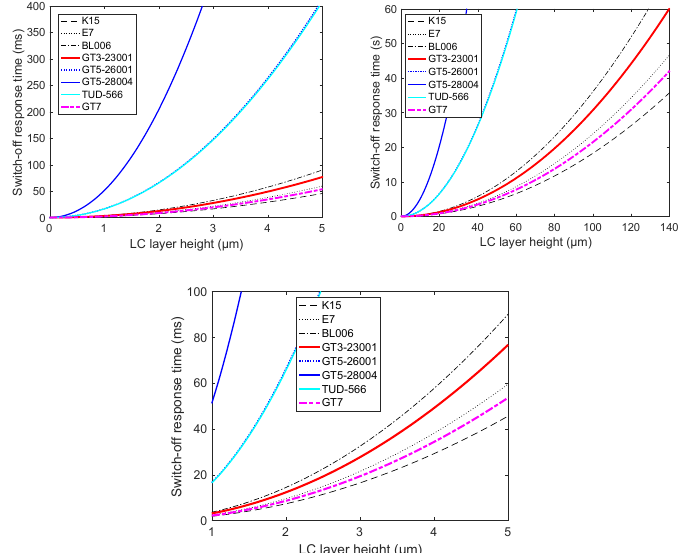
Figure 8. Switch-off response time of a parallel-plate capacitor cell filled with LCs from Table 1 versus the LC layer height up to 5 µ m ( left ) and up to 140 µ m ( right ). The curves for TUD-566 and GT5-26001 are nearly identical . The lower plot is a zoom out.